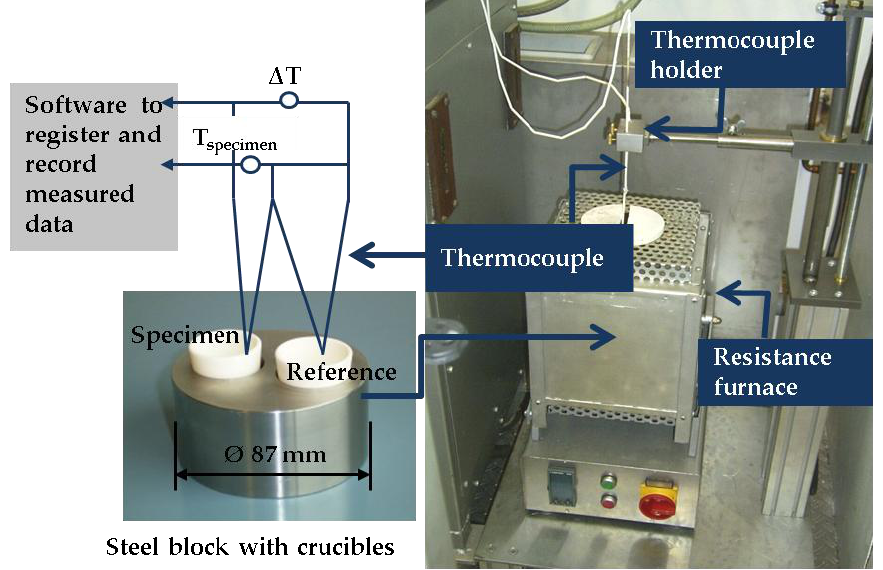
Figure 4. Equipment for large scale Differential Thermal Analysis (DTA) at IME.